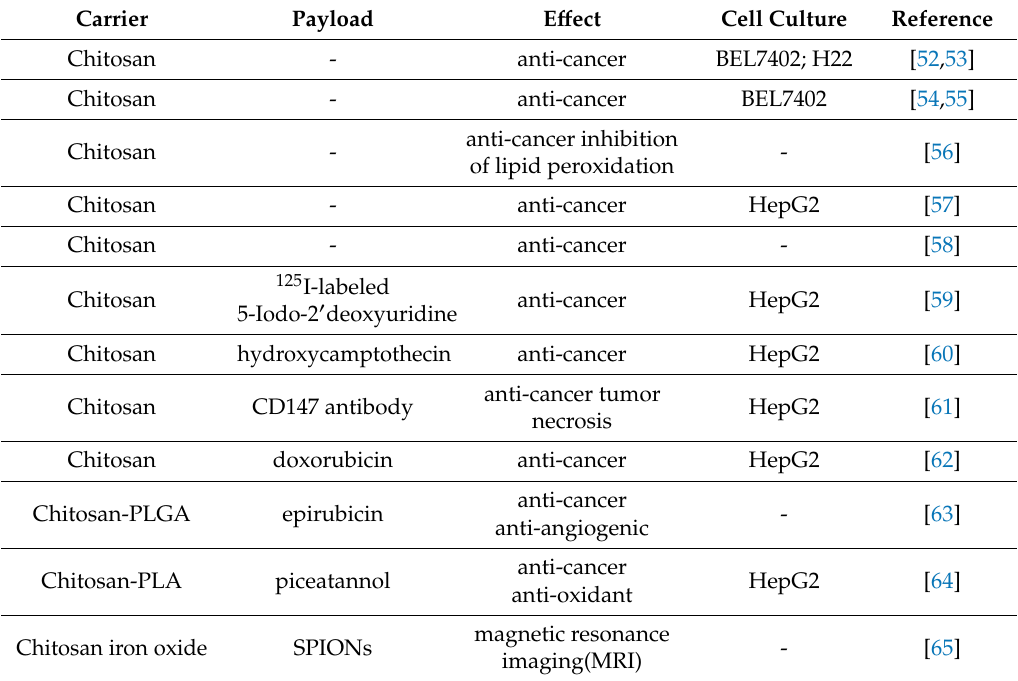
Table 1. Chitosan nanoparticles designed for the treatment of HCC and liver-targeting: the therapeutic / theranostic e ff ect and cell cultures used in the study are reported for each reference.